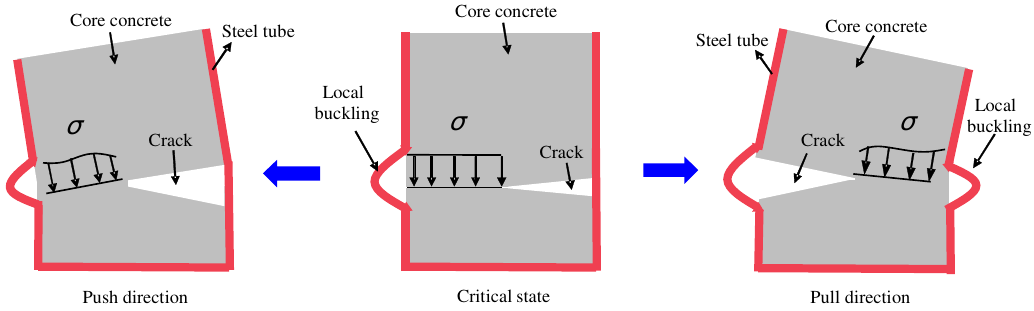
Figure 2. The schematic diagram of local buckling under complex actions.